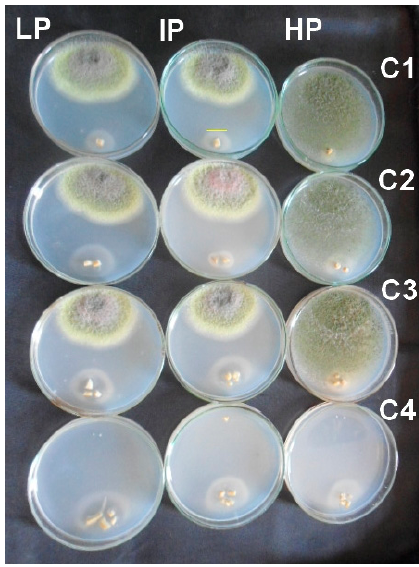
Figure 8. Antifungal activity for different concentration of Cu-Chit/NCs gel (C1 = 60, C2 = 120, C3 = 180, and C4 = 240 ppm) against A. flavus isolated from feeds by the plate assay. All Petri dish treatments were incubated at 28 °C for one week. Table 2. Antifungal activity of Cu-Chit/NCs gel against three Aspergillus flavus strains . Serial Number NCs Gel Concentrations